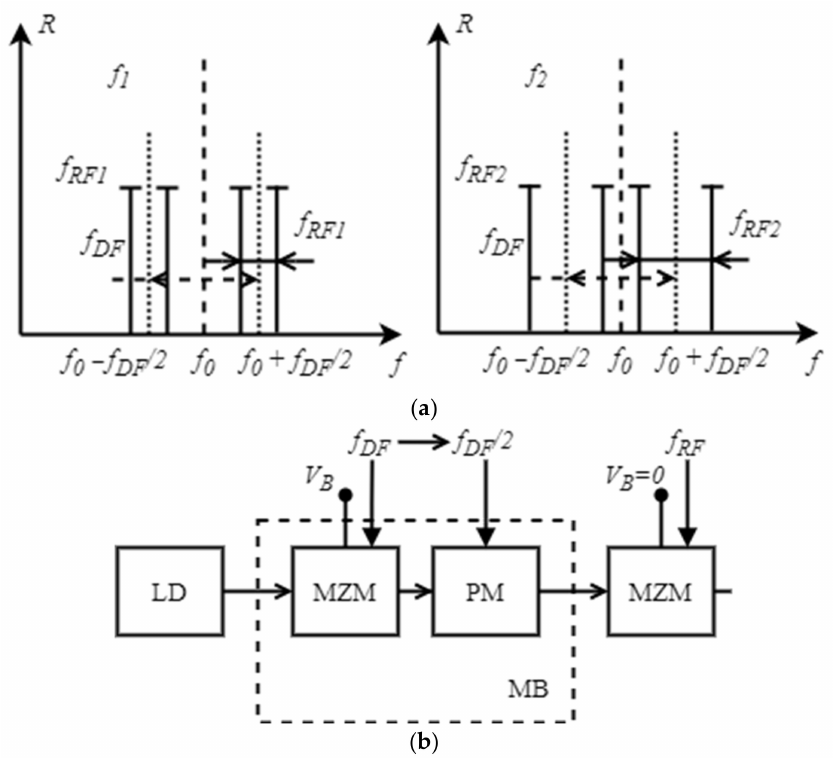
Figure 8. IFM method with additional frequency separation: ( a ) Explanation of the operation principle; ( b ) block diagram of the transmitting part. LD—Laser diode; MZM—Mach–Zehnder modulator; PM—Phase modulator; MB—Modulator block (adapted from